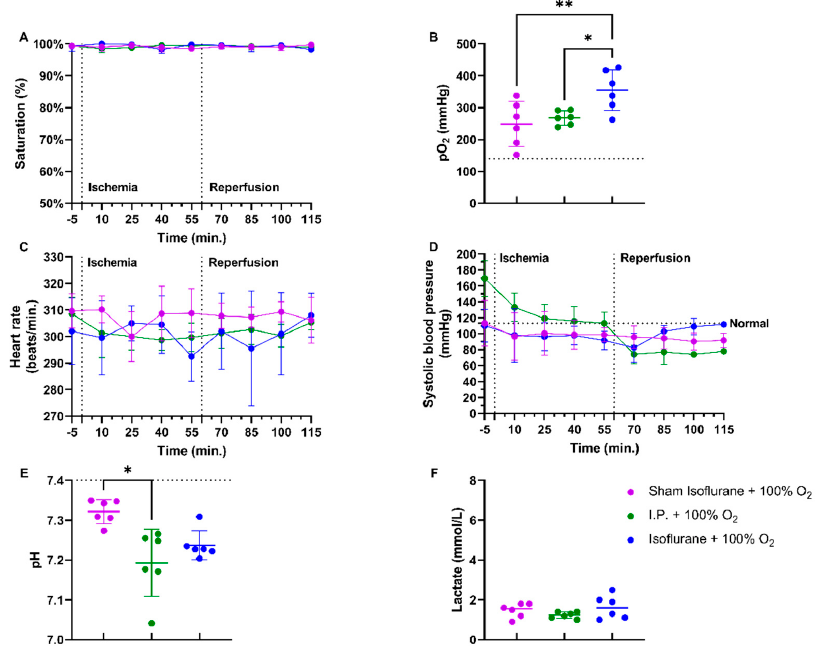
Figure 5. Impact of isoflurane on hemodynamic parameters during intestinal ischemia-reperfusion injury: saturation ( A ), partial oxygen pressure (pO 2 ) ( B ), heart rate ( C ), and systolic blood pressure ( D ). After 60 min of reperfusion, pH ( E ) and lactate ( F ) were measured on arterial blood gas. ( n = 6/group). I.P.: intraperitoneal injection anesthesia; O 2 : oxygen. Normal values are shown by a horizontal dashed line in graphs ( C , D ). Onset of ischemia and reperfusion are shown by vertical dashed lines in graphs ( A – C ). * p < 0.05; ** p < 0.01. 2.2.2. Isoflurane Protected against Histopathological Damage and Preserved Intestinal Permeability, Provoked by IRI